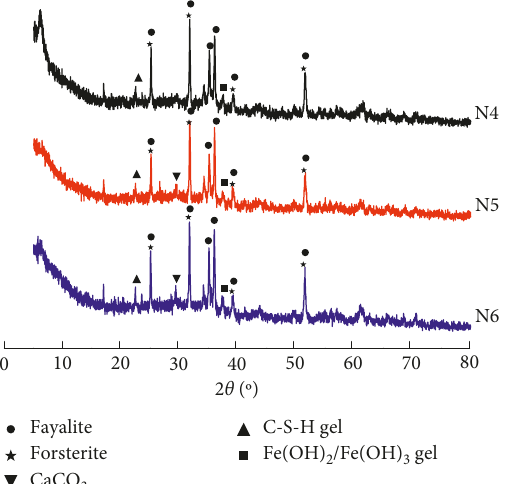
Figure 9: XRD patterns of CNSCMs cured under different levels of humidity for